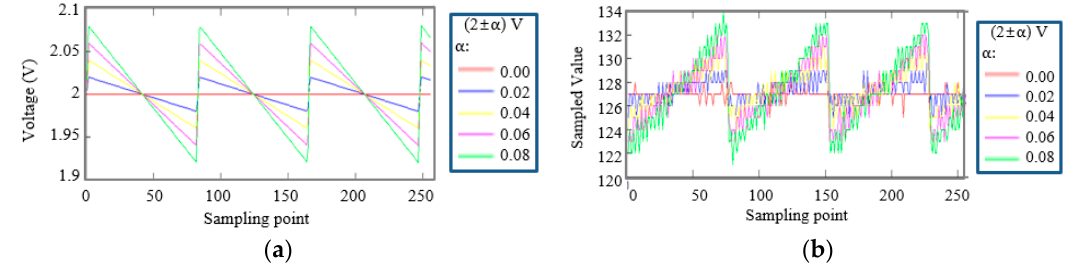
Figure 5. The sampled ADC data when an ADC was powered by a ramp signal. ( a ) Supply voltage signals with a (2 ± α ) V ramp shape, and ( b ) the sampled ADC data.